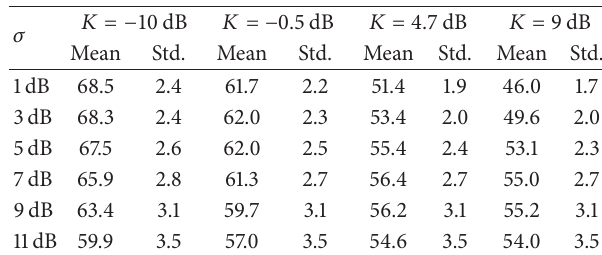
Table 1: Standard deviation and mean value of capacity for an 8 × 8 MIMO system with SNR = 30 dB in composite fading.